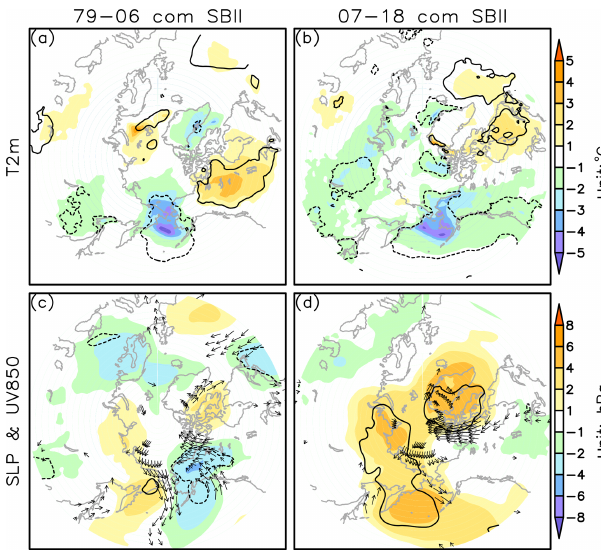
Figure 3. Composites of March–April–May (a, b) 2m air tempera- ture anomalies; (c, d) sea level pressure (color shading) and 850hPa wind (vectors) anomalies based on the SBII high minus low index during the pre-2007 period (a, c) and the post-2007 period (b, d) . Solid (dashed) lines enclose the positive (negative) values that are significant at the 95% confidence level. For 850hPa wind vectors, only the meridional wind anomalies that are significant at the 95% confidence level are